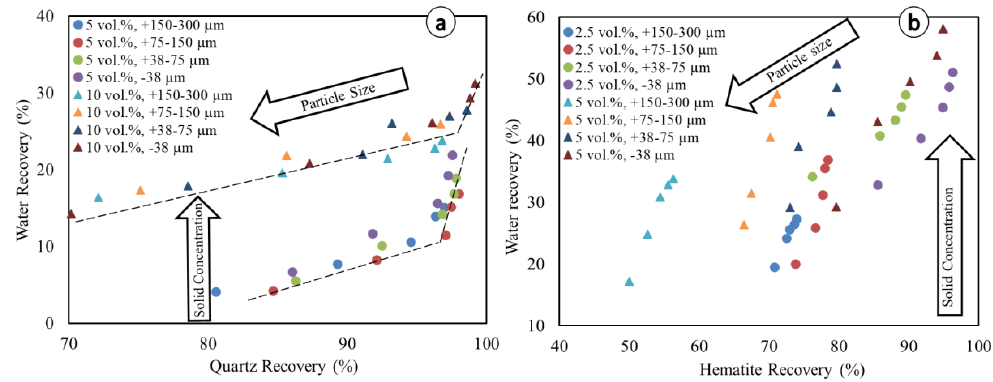
Figure 7. Relationship between mineral water recovery and particles recovery. ( a ) Quartz